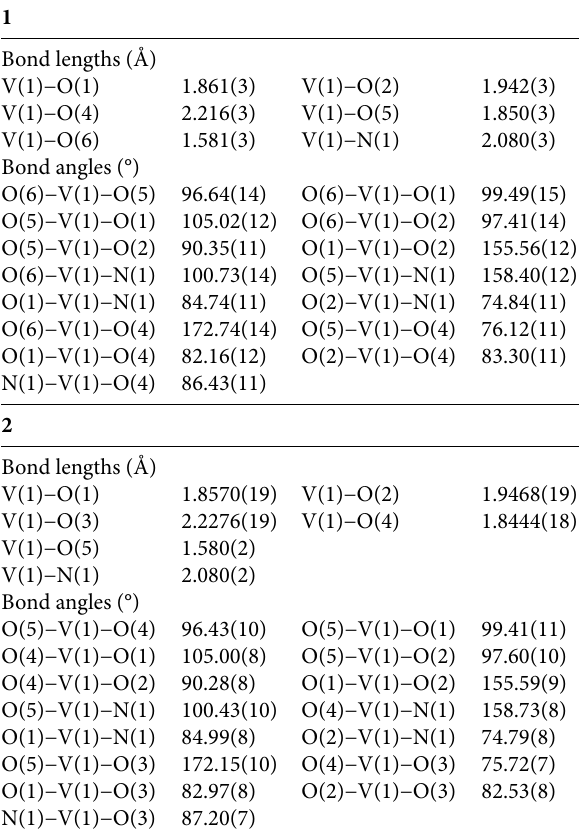
Table 2. Selected bond lengths (Å) and angles (°) for the complexes